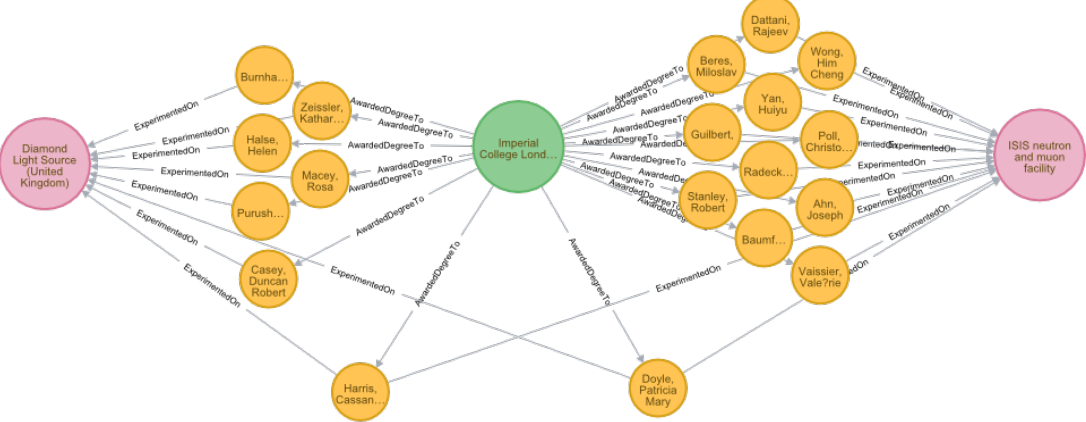
Figure 2. The subgraph with Imperial College London PhD students who experimented on two research facilities. Imperial College London is indicated by the central node, the research facilities are represented by the nodes on the left and on the right and the students by the smaller nodes in between. The two nodes at the bottom illustrate two students who used both facilities in their research.